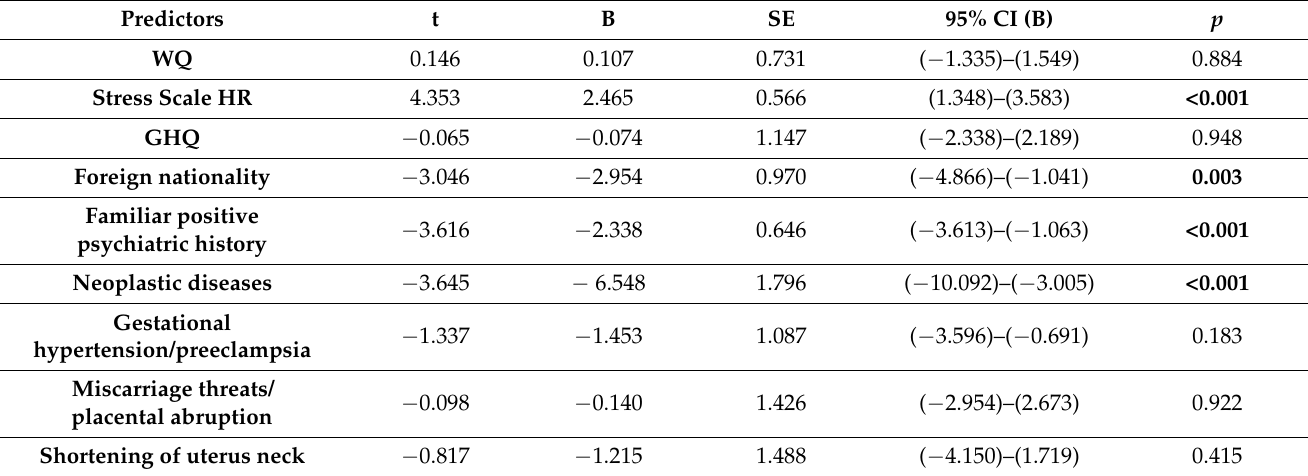
Table 5. Multiple linear regression analysis (outcome = EPDS total